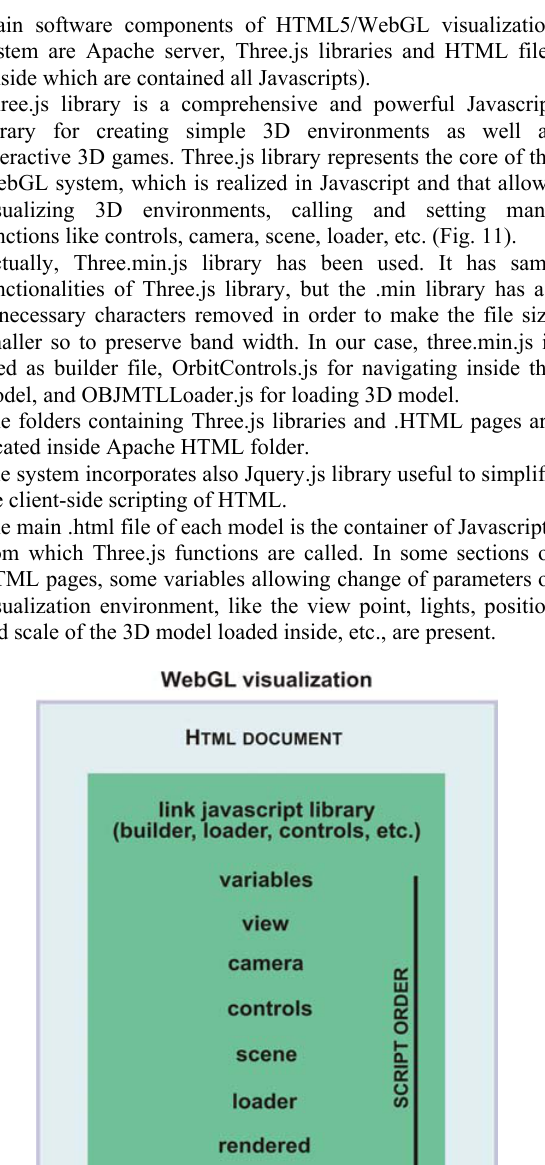
Figure 13. Structure of online